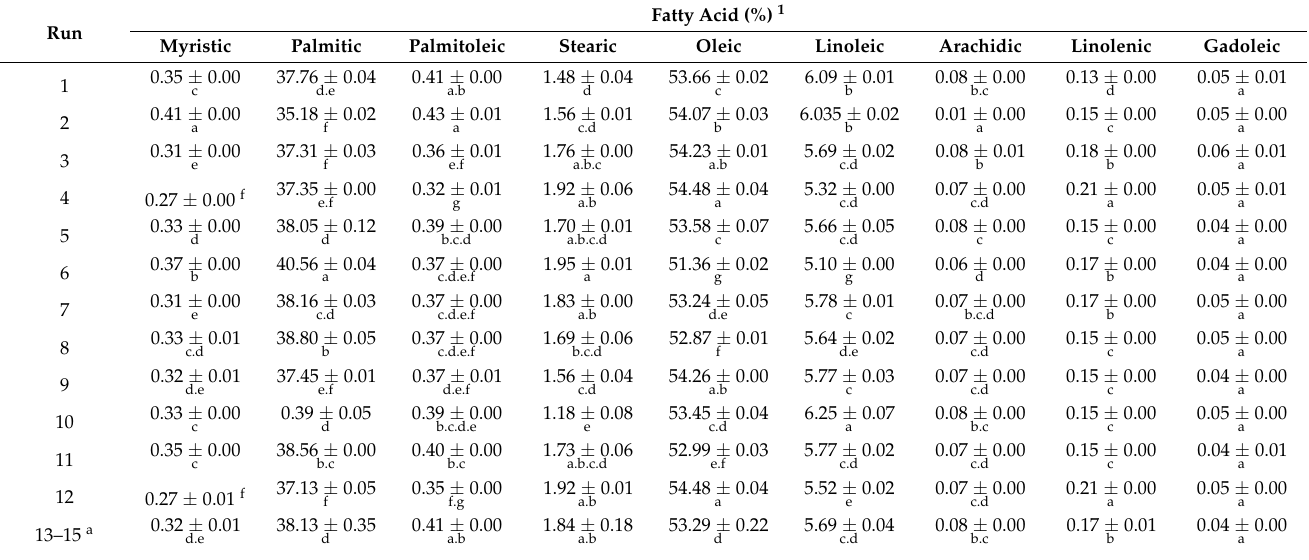
Table 4. Fatty acid profile of pequi almond oils obtained by supercritical CO 2